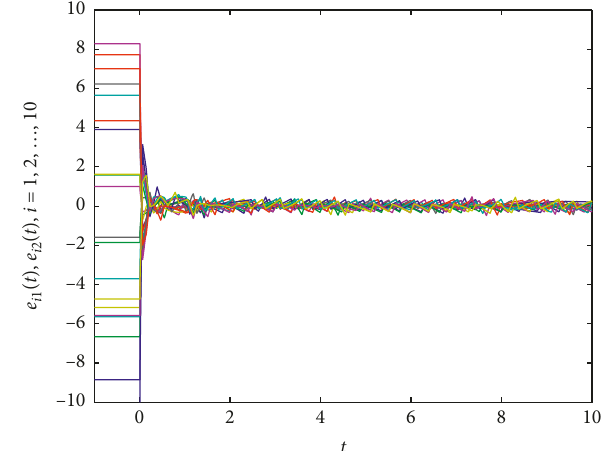
Figure 9: Time evolution of nodes’ states x � 0 . 5 under sampled-data feedback, i � 1 , 2 , ... , with θ 0 � 0